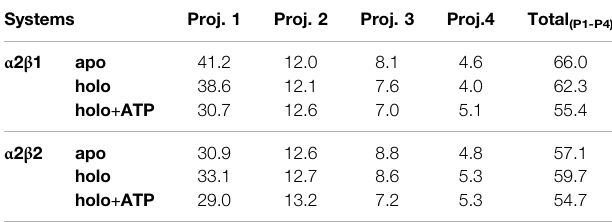
TABLE 2 | Contribution of the essential motion (%) to the structural variance of different AMPK systems and the total contribution of the fi rst four